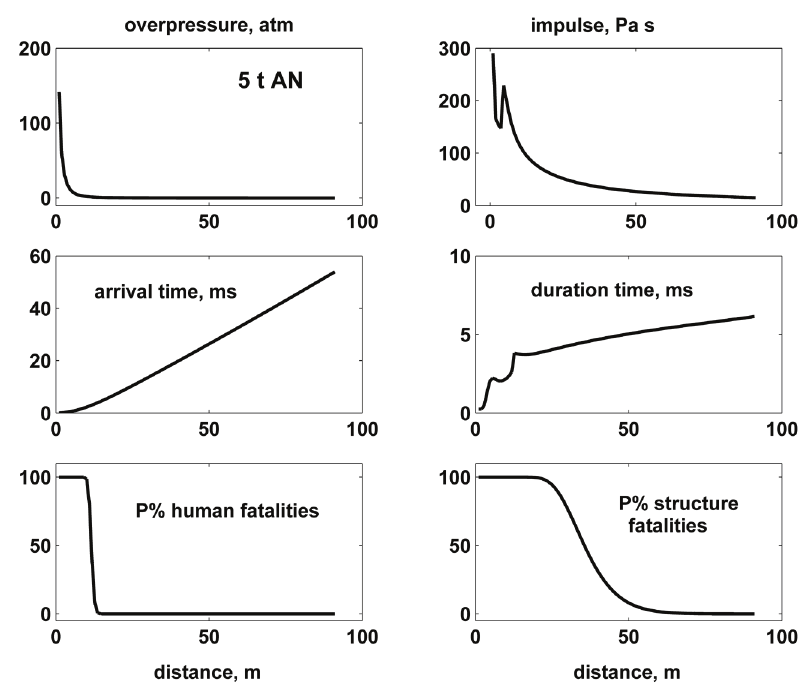
Fig. 5 – Blast parameters and P% fatalities for humans and structures at various dis - tances from the explosion location (case of 5 t AN